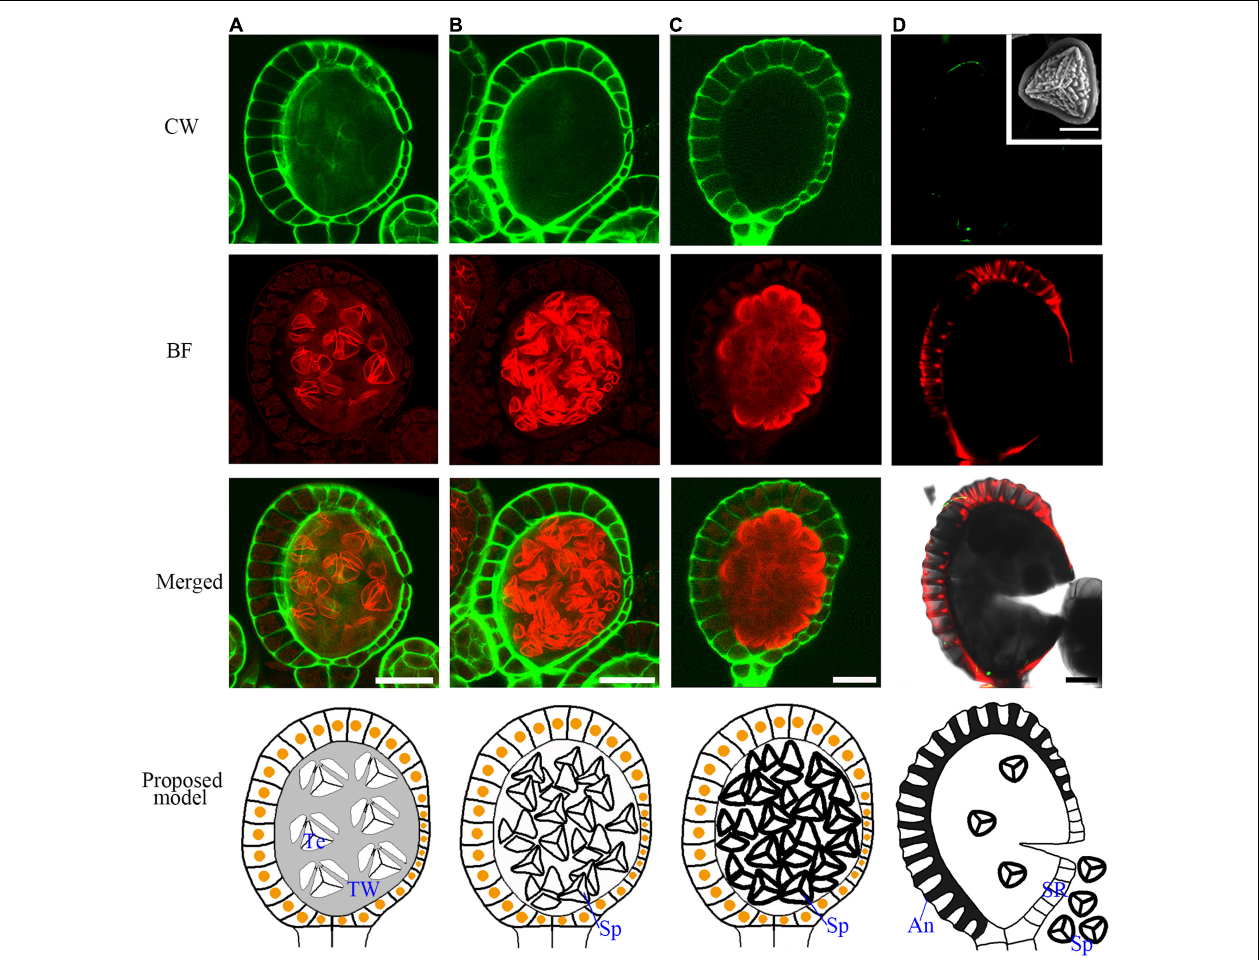
FIGURE 6 | The mature spore formation and the lignification of the annulus in the epidermis for sporangium dehiscence. (A–C) The spores are released from tetrads in the spore sac and the spore wall is gradually thickened. (D) The annulus in the epidermis cells are lignified and mature spores are released from the sporangia. The SEM picture of the inset shows a mature spore. Scale bar = 20 µ m. CW signals are colored green. BF signals are colored red. Scale bar = 50 µ m. (A–D) Proposed models are shown on the right of each inset. An, annulus; TW, tetrads wall; SR, stomial region; Te, tetrad; Sp,